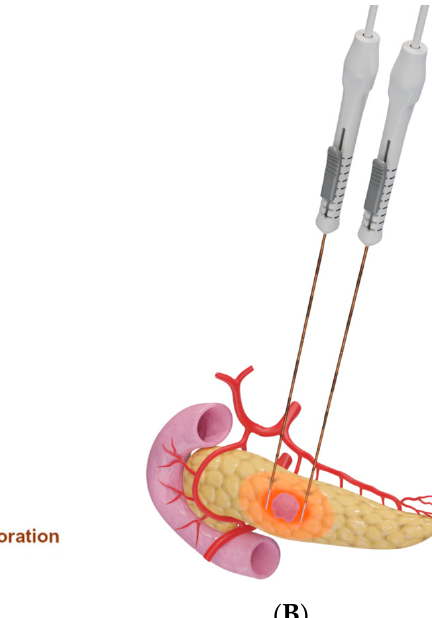
Figure 5. Schematic presentation of irreversible electroporation . ( A ) Two IRE probes are placed in parallel around the tumor, whereby multiple high-voltage electrical pulses are delivered to produce a uniform zone of ablation [26]; ( B ) Representative example of IRE used to target a pancreatic tumor.